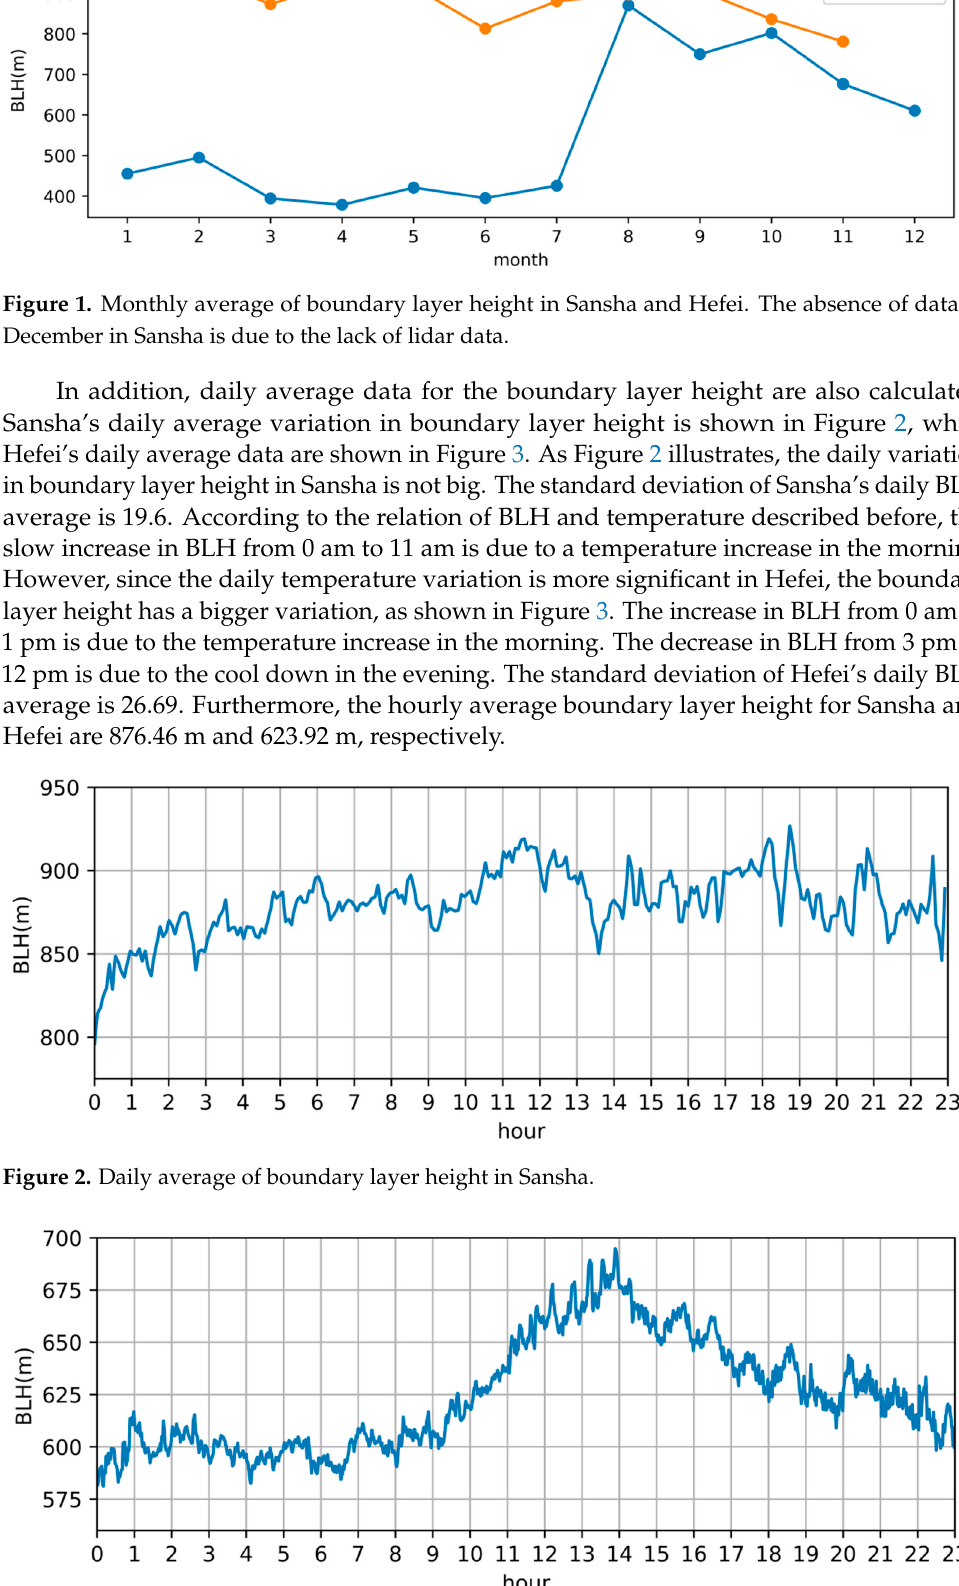
Figure 3. Daily average of boundary layer height in Hefei.